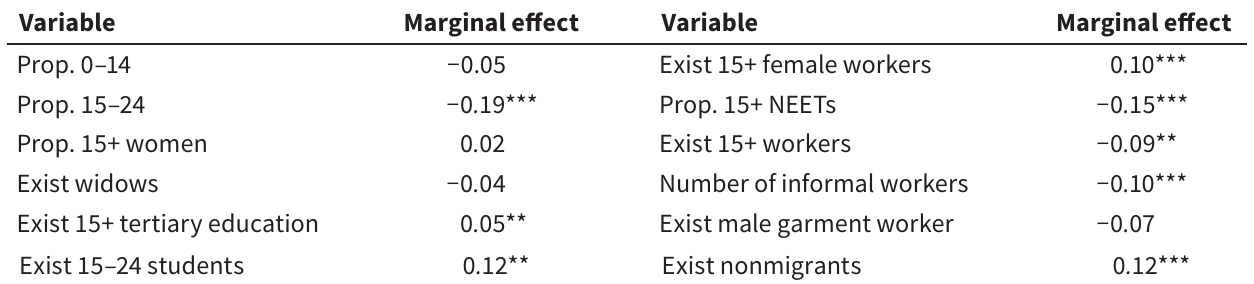
Estimates of the probability of being a “standard” migrant family, marginal effects